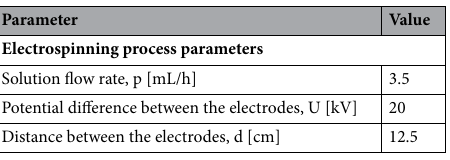
Table 2. Parameters for electrospinning PAN/PANI